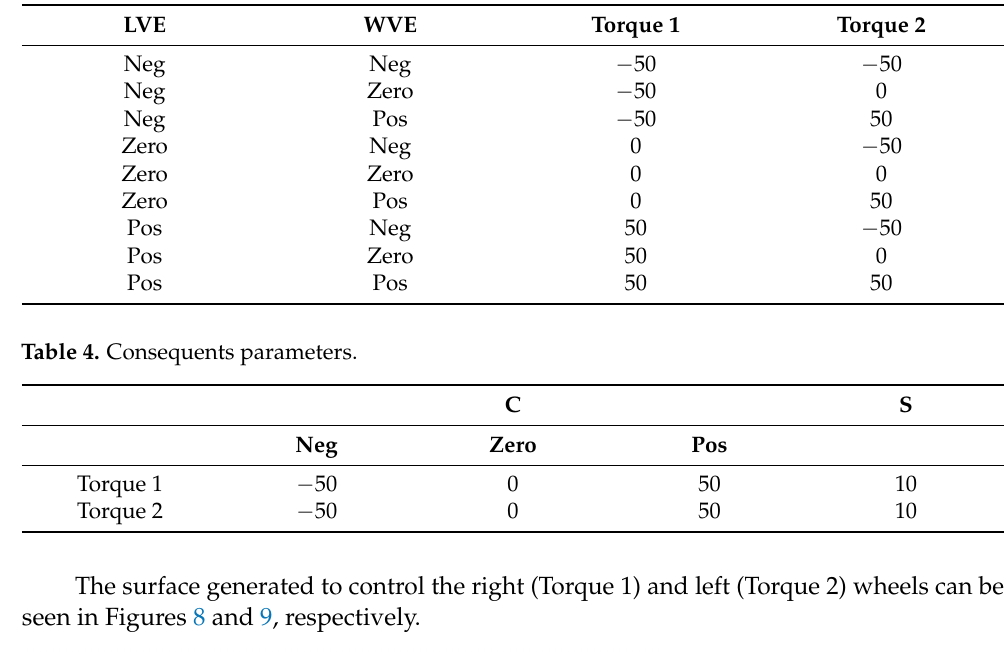
Table 3. Rules for the IT3FC mobile robot system.